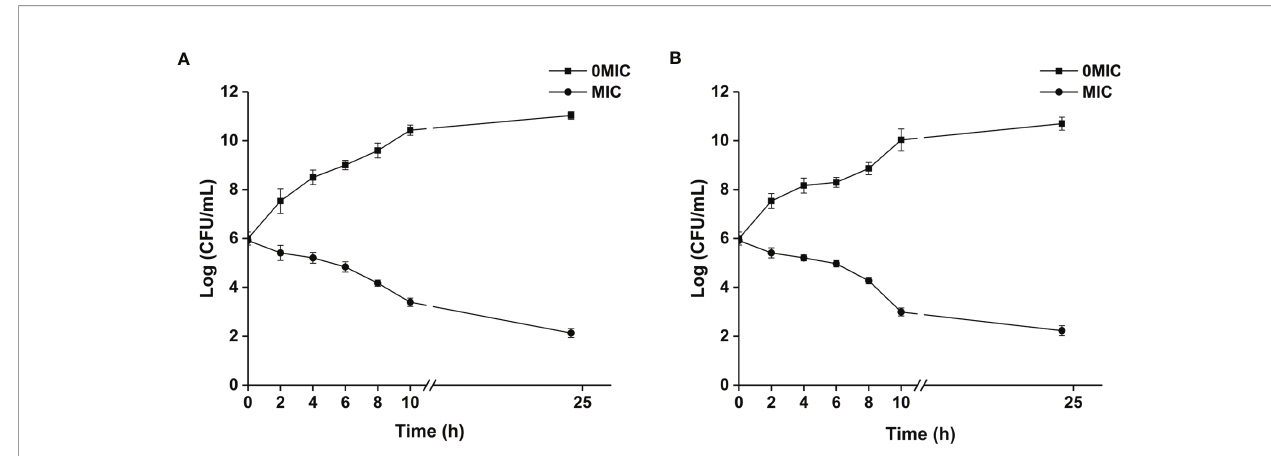
FIGURE 1 | The growth kinetics of C. albicans SC5314 (A) and C. neoformans H99 (B) in response to paeonol were determined. The growth kinetics of fungal cells in the presence and absence of paeonol at an MIC concentration were plotted. All data were expressed as means ± SD ( n =